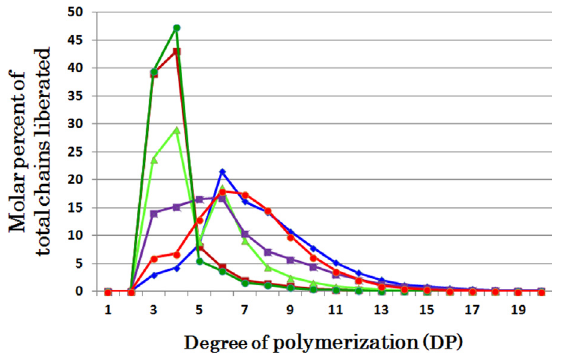
Fig 8. Chain-length preference of ISA-type DBEs in debranching phytoglycogen. The amount of chains liberated after enzymatic reaction with phytoglycogen and OsISA1 (blue ♦ ), OsISA3 (brown ■ ), CytISA (green ▲ ), ScoISA (purple ■ ), EcoGlgX (dark green ● ), and PsaISA (red ● ), respectively. The total amounts of liberated chains out of total chains of the substrate glucan phytoglycogen (982 nmoles) by reactions with OsISA1, OsISA3, CytISA, ScoISA, EcoGlgX, and PsaISA were 81, 68, 88, 74, 66, and 68 nmoles, respectively. These data were chosen from Figs 1, 3, 4, 5, 6 and 7,